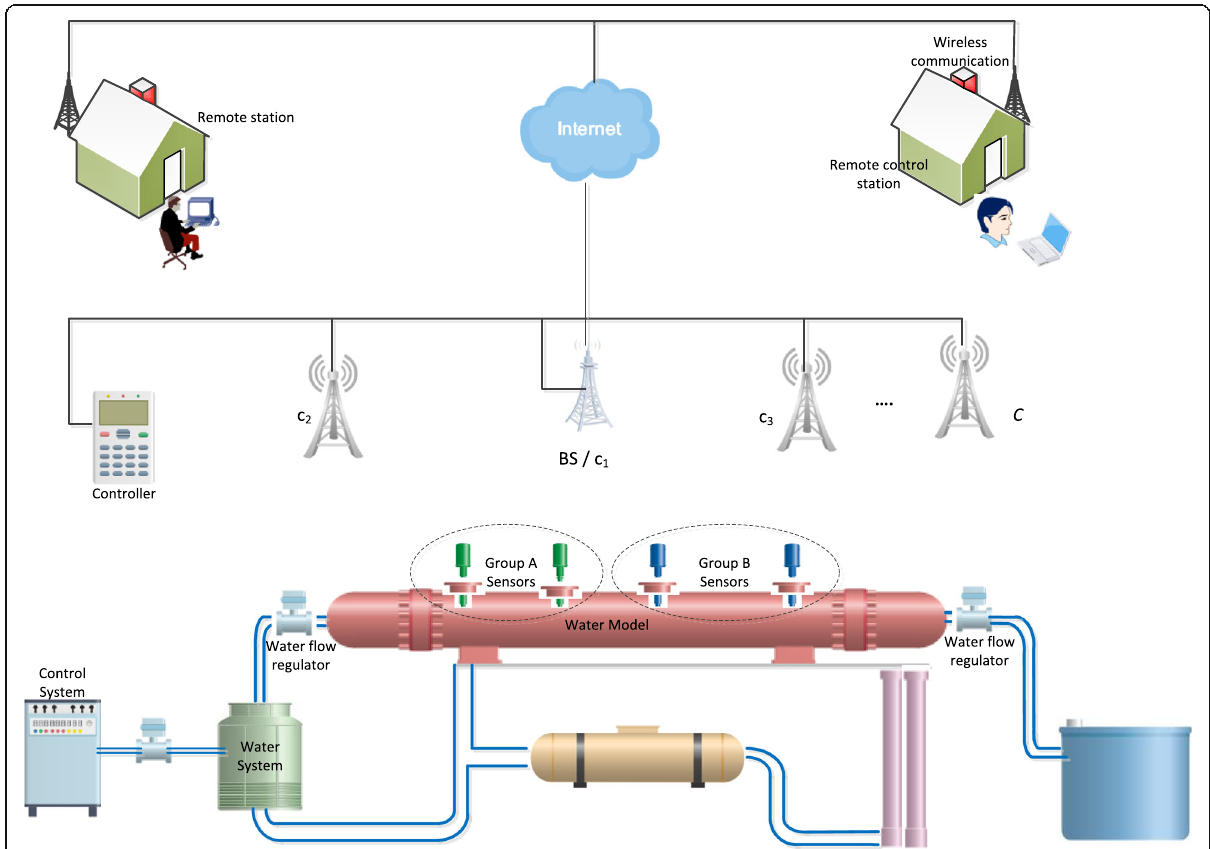
Fig. 2 Proposed model for water quality monitoring in a water processing